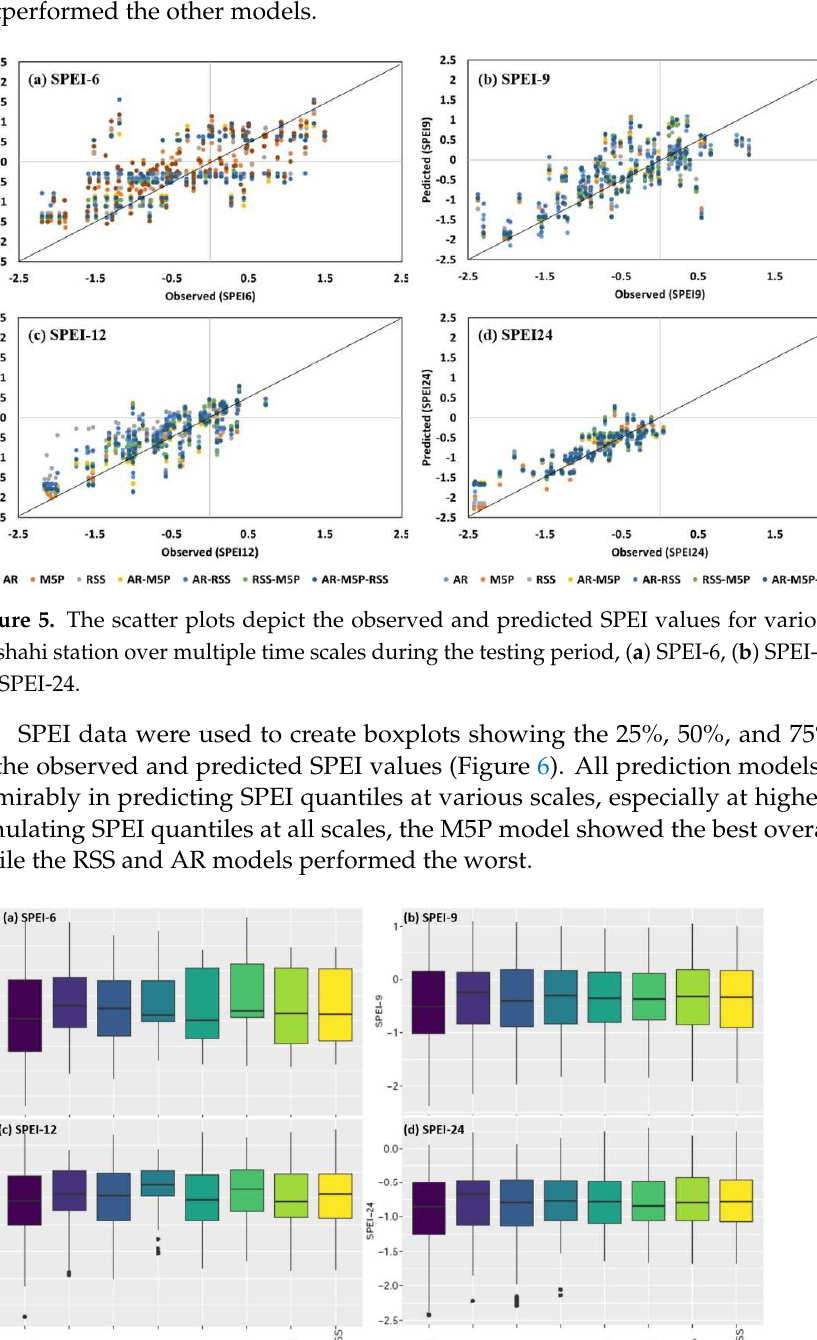
Figure 6. Predictive model performance at Rajshahi station over multiple time scales during the testing period, ( a ) SPEI-6, ( b ) SPEI-9, ( c ) SPEI-12, ( d ) SPEI-24.